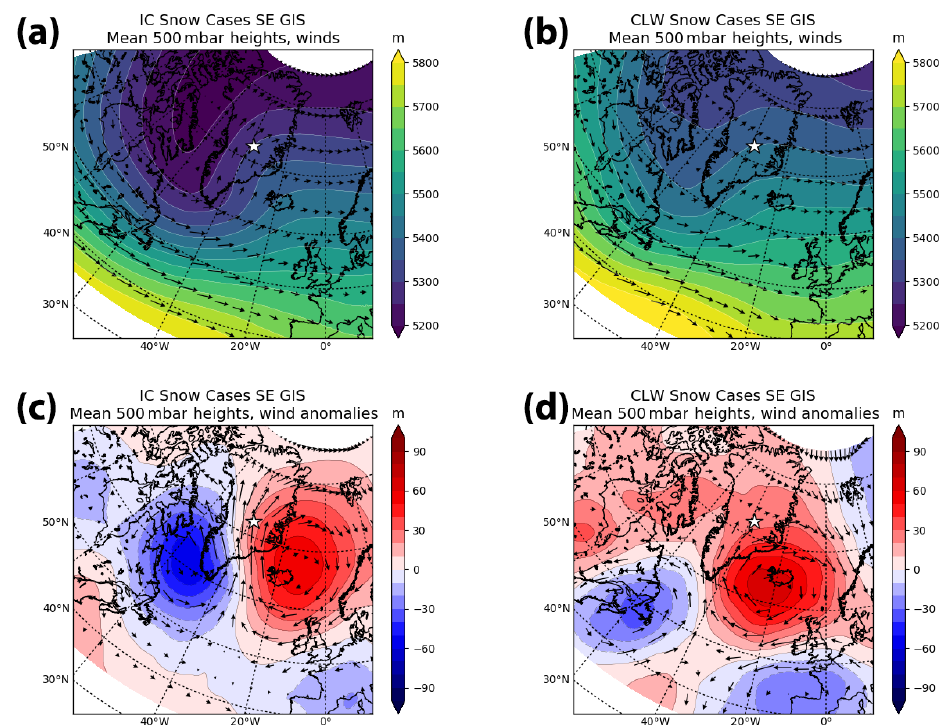
Figure 17. As in Fig. 14 but for the southeastern GrIS: basins 3.3, 4.1, 4.2, 4.3, and